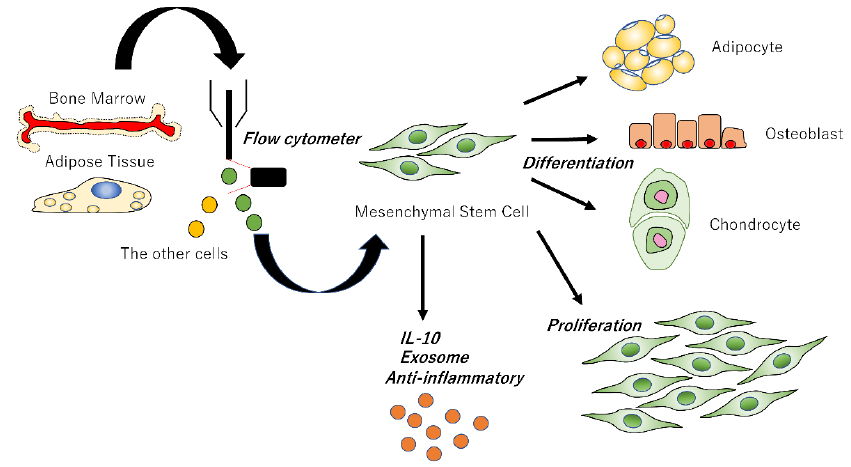
Figure 2. Isolation and differentiation of high-grade mesenchymal stem cells.